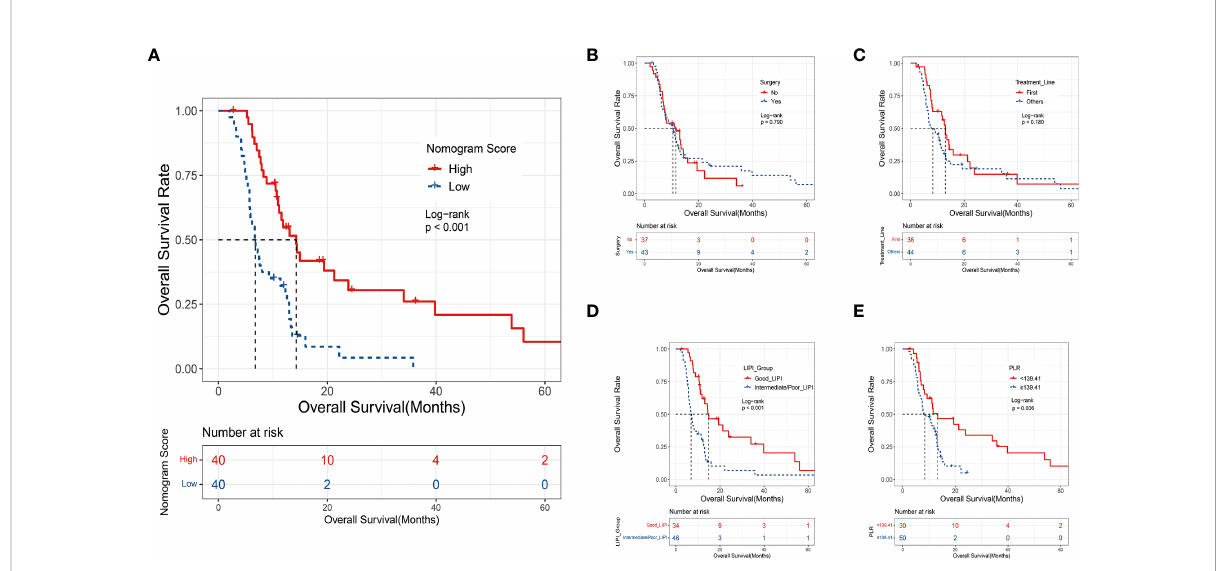
FIGURE 5 (A) The KM curve of the validation set based on the median score of the nomogram model; (B) the KM curve of the validation set based on surgery history; (C) the KM curve of the validation set based on treatment line; (D) the KM curve of the validation set based on the LIPI group; (E) the KM curve of the validation set based on the PLR group.